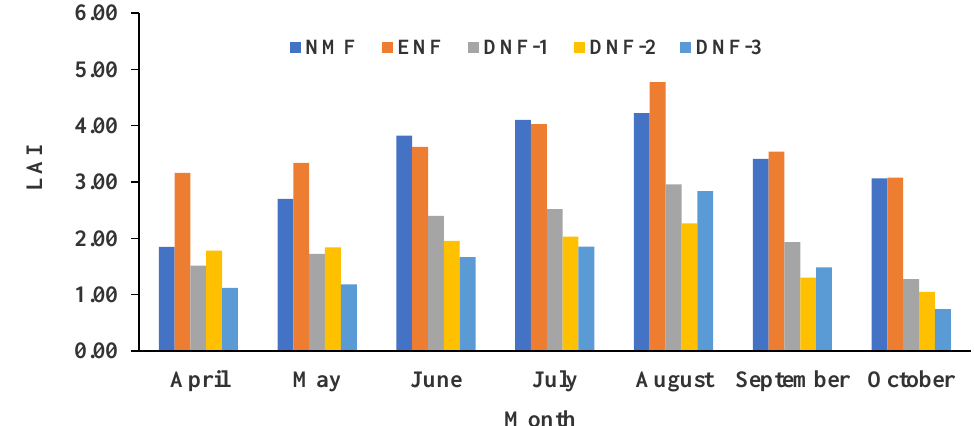
Figure 4. The seasonal variations of leaf area index (LAI) from April to October 2015.